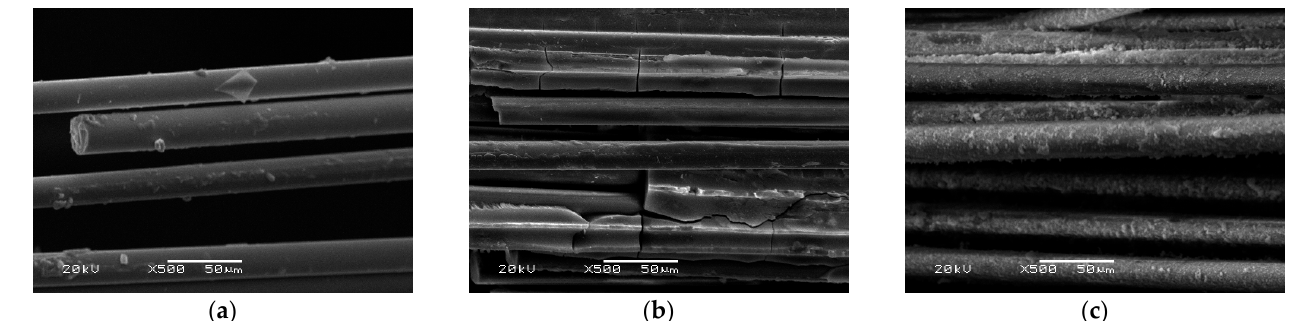
Figure 15. SEM image: Glass fiber: ( a ) as delivered; ( b ) from a sample based on a fly ash matrix; ( c ) from a sample based on a metakaolin matrix.